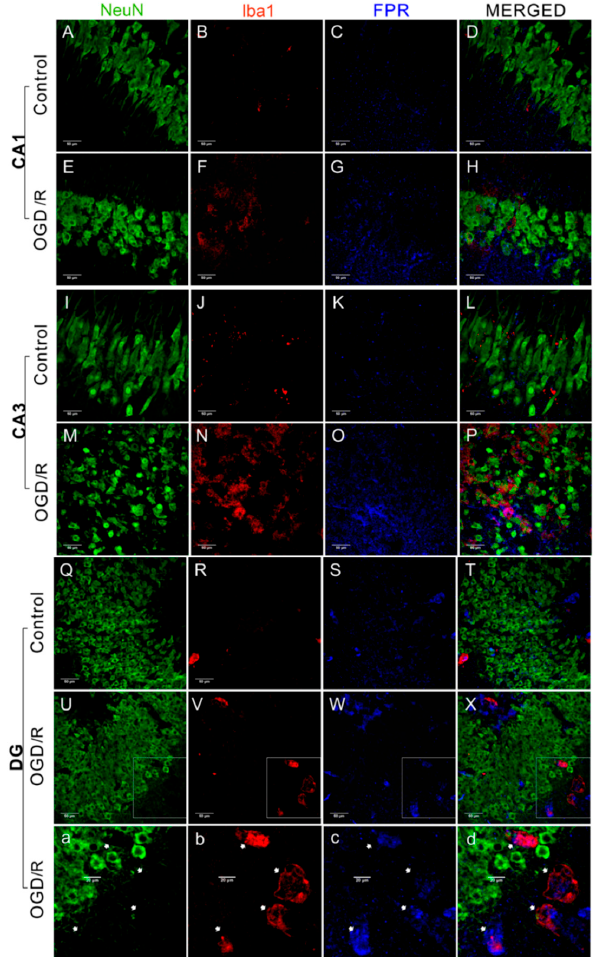
Figure 3. Immunofluorescence imaging revealed that formyl peptide receptors (FPRs) were rarely co-localized with neurons in hippocampal slices. ( A – X , a – d ) Examples of a neuron-specific nuclear protein (NeuN)-labeled neuron ( green ), Iba1-labeled microglia ( red ), and FPR-positive particles ( blue ). The white arrows point at labeled cells and the corresponding area. Scale bar: 50 μ m.